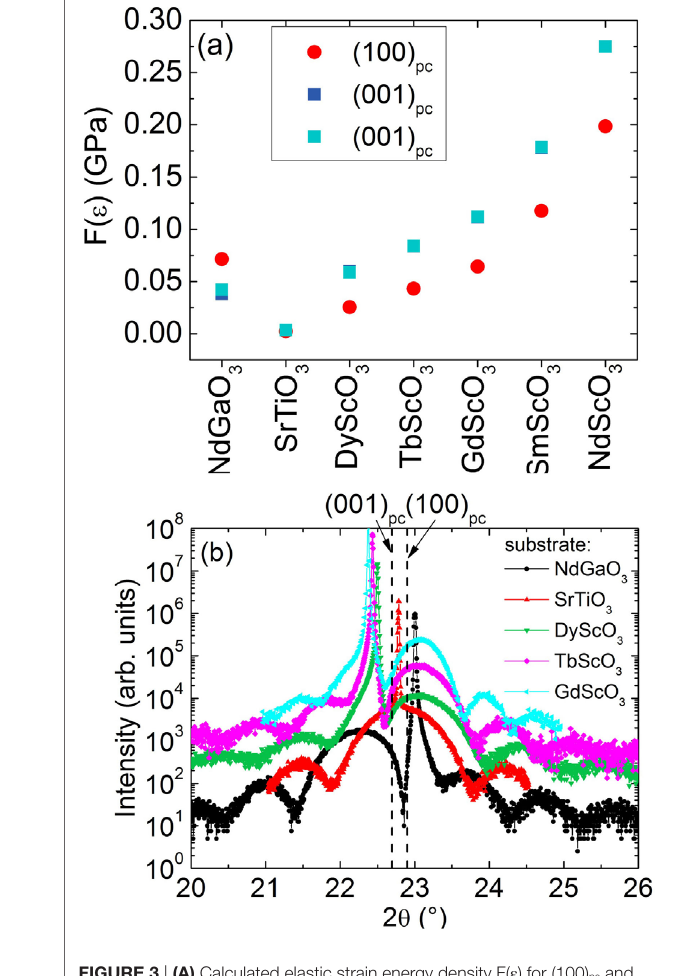
indicates compressive lattice strain in a (001) pc oriented NaNbO 3 film. By contrast, the angular positions of film Bragg reflections on ReScO 3 (Re = Dy, Tb, Gd) substrates occur at larger values than the corresponding bulk (100) pc position. This points to (100) pc oriented NaNbO 3 thin films grown under tensile lattice strain. Film orientation and strain state of NaNbO 3 on SrTiO 3 cannot be unambiguously determined due to the overlapping of film and substrate peak and the large angular width of the film peak, which is caused by the small film thickness. Summarizing, we conclude that the NaNbO 3 film orientation switches from (001) pc on NdGaO 3 to (100) pc on ReScO 3 (Re = Dy, Tb, Gd) in agreement with the elastic strain energy calculations ( Figure 2A ). Concomitantly, the vector of electrical polarization rotates from mainly vertical to exclusive in-plane orientation (Schwarzkopf et al., 2014). Hence, an exact prediction of the unit cell orientation can be made as first step for domain